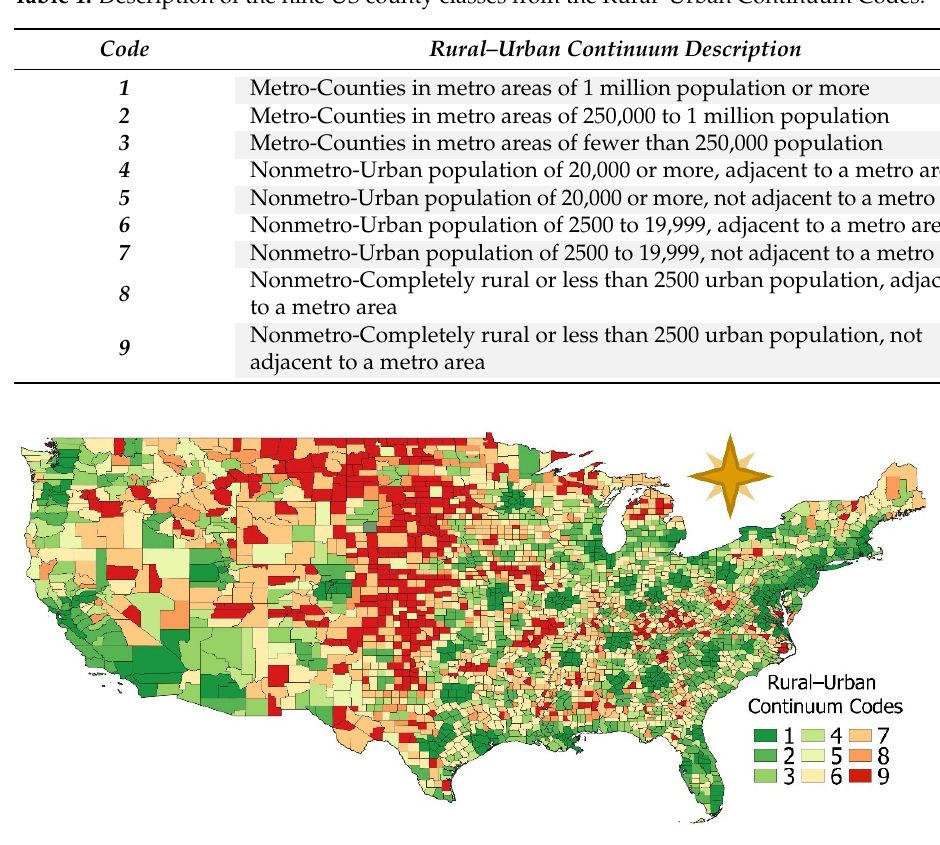
Figure 3. Counties in the US classified according to the Rural–Urban Continuum Codes as indicated by USDA.